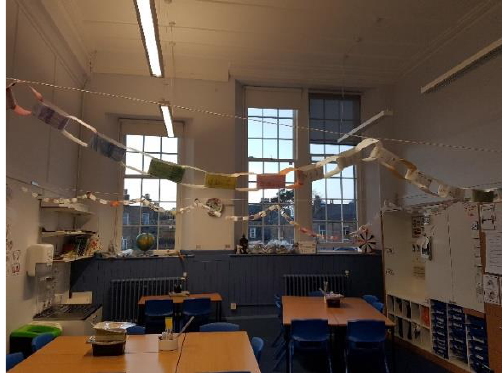
Figure 11. Picture of classroom C3.